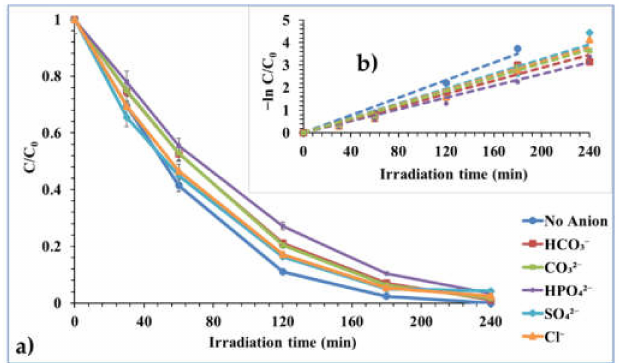
Figure 15. ( a ) Anion effect on the photocatalytic degradation performance of 1 g/L Mo/SynTiO 2 over 5 mg/L initial CBZ concentration under natural (unmodified) pH 5.84 and 365 nm irradiation, and ( b ) their corresponding photocatalytic degradation rate constant